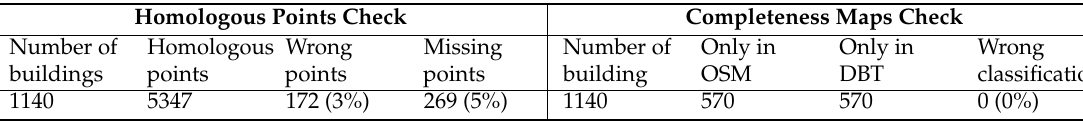
Table 2. Validation of the assessment of spatial accuracy and